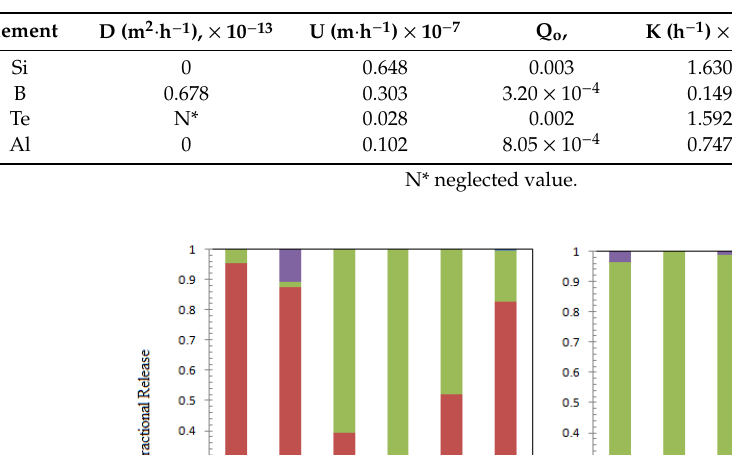
Table 11. Nonlinear curve fitting parameters of the cumulative leach fraction of metalloid and post-transition elements: ABS-Waste (25).